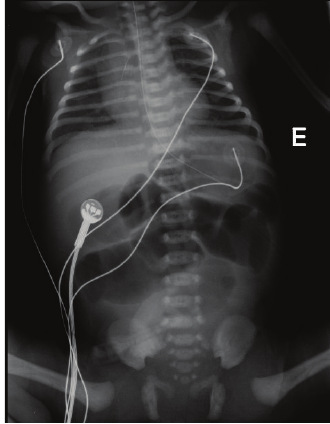
Figure 4: Intestinal distension and air fluid levels.